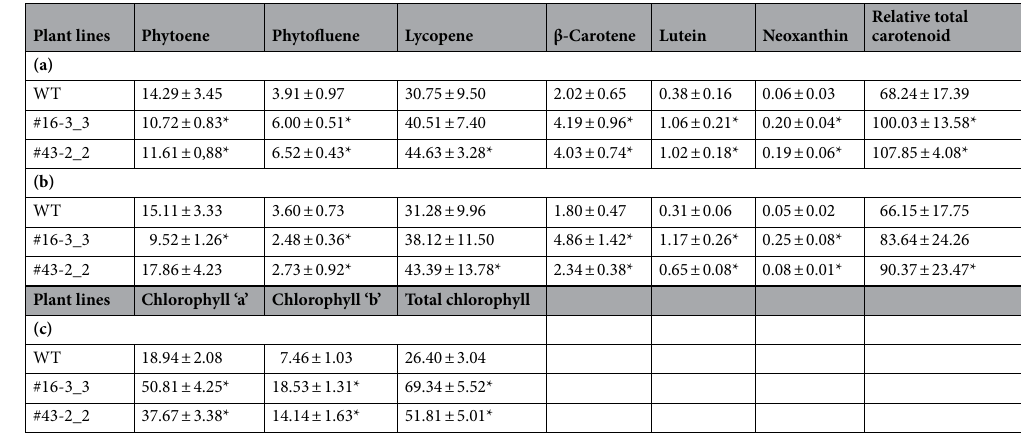
Table 3. Carotenoid content in µg g −1 FW of T 1 and T 2 segregant null at red ripe fruits and chlorophyll contents of T 2 segregants at green mature fruits. (a) and (b) The carotenoid content was measured in the fruit pericarp by HPLC at the breaker-stage + 12 days (12 DPB) in T 1 null plants and T 2 segregants, respectively. Concentrations are expressed in µg g −1 FW. (c) The chlorophyll content was measured in the fruit pericarp by spectrophotometry at the green mature stage (28 DPA) in T 2 segregants. Concentrations are expressed in µg g −1 FW. Statistical analysis with T-test independent variable was performed between the mutated lines to the control line for T 1 and T 2 for carotenoid content and for chlorophyll content, with significant differences were considered to exist at p < 0.05. *Means significantly different at